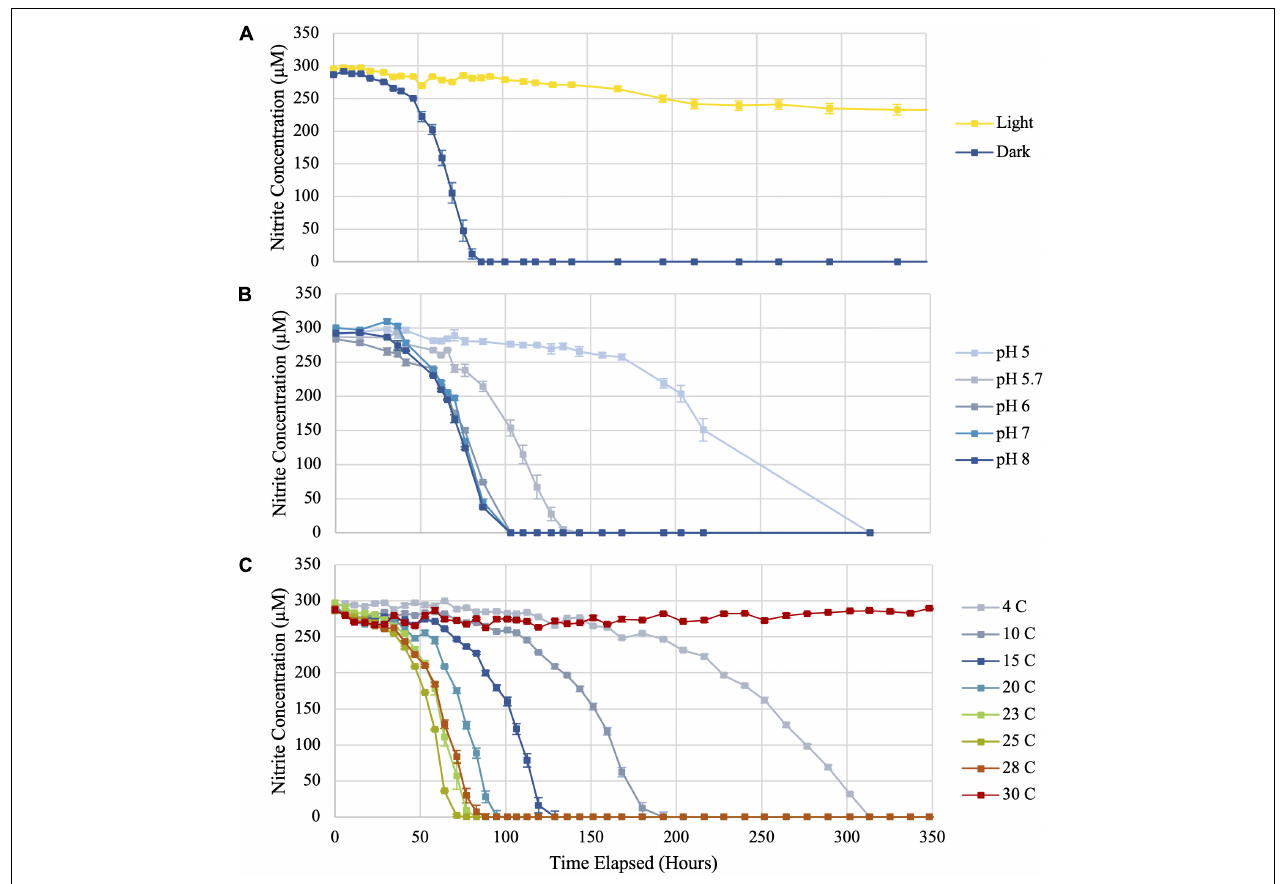
FIGURE 2 | Nitrite utilization by Ca . Nitrotoga sp. CP45 when (A) exposed to continuous light compared to incubation in darkness, (B) grown in media at varying pH values, and (C) incubated at eight different temperatures (4, 10, 15, 20, 23, 25, 28, and 30 ◦ C). Values plotted are averages of triplicate vials at each sampling time point with error bars representing ± the standard error of the mean (SEM). If not visible, error bars are smaller than data